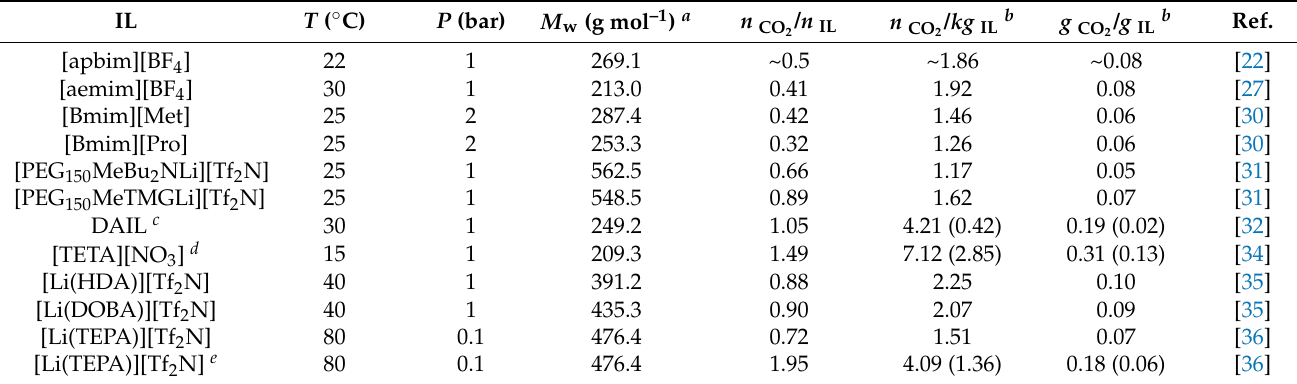
Table 1. Typical cation-functionalized ILs for CO 2 capture.